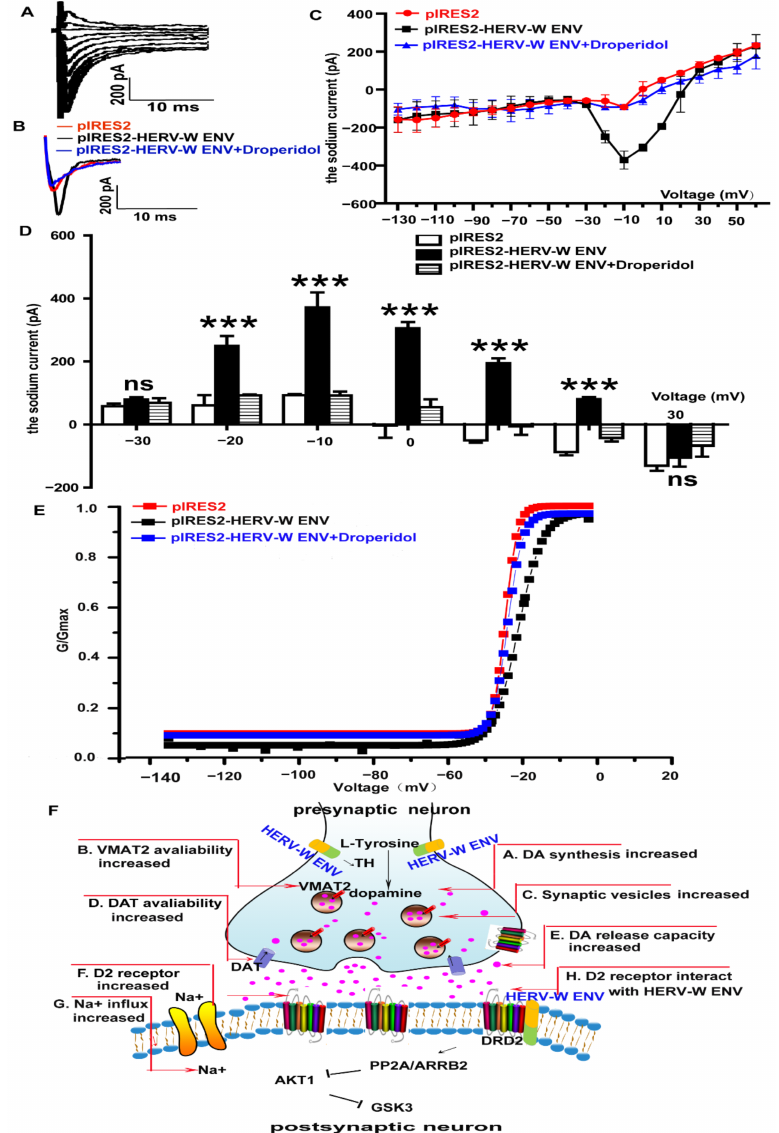
Figure 7. HERV-W ENV enhances the sodium influx through DRD2/PP2A/AKT1/GSK3 in the DA neurons: ( A ) a representative set of sodium current traces from SH-SY5Y cells that were elicited